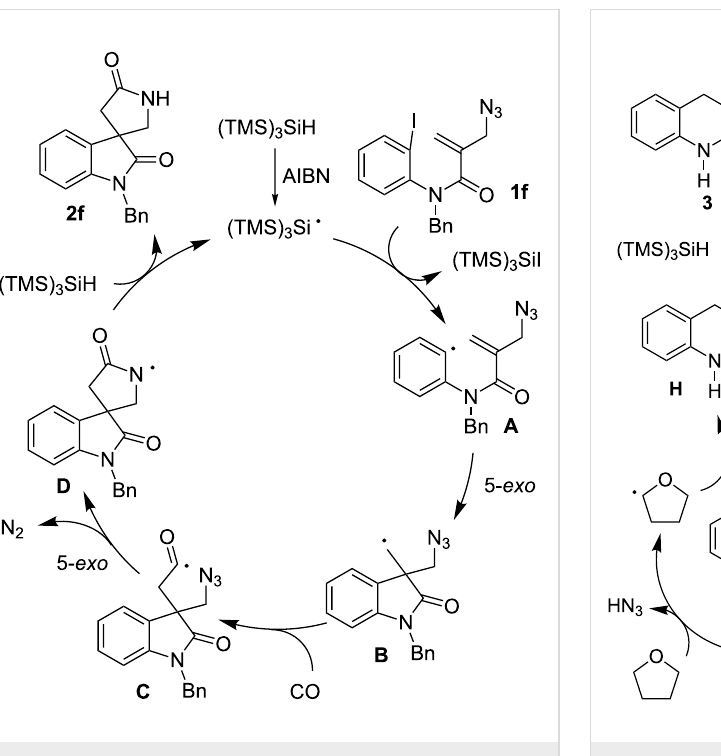
Scheme 5: Proposed mechanism for a construction of 4,4-spirocyclic indoline γ -lactam 2f by the tandem radical cyclization of 1f with CO.